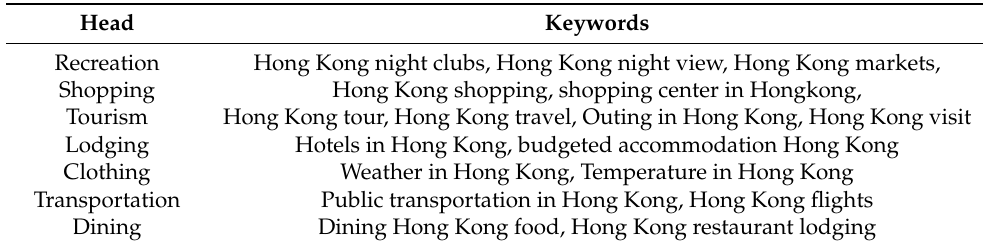
Table 1. SII seed search keywords under the study.